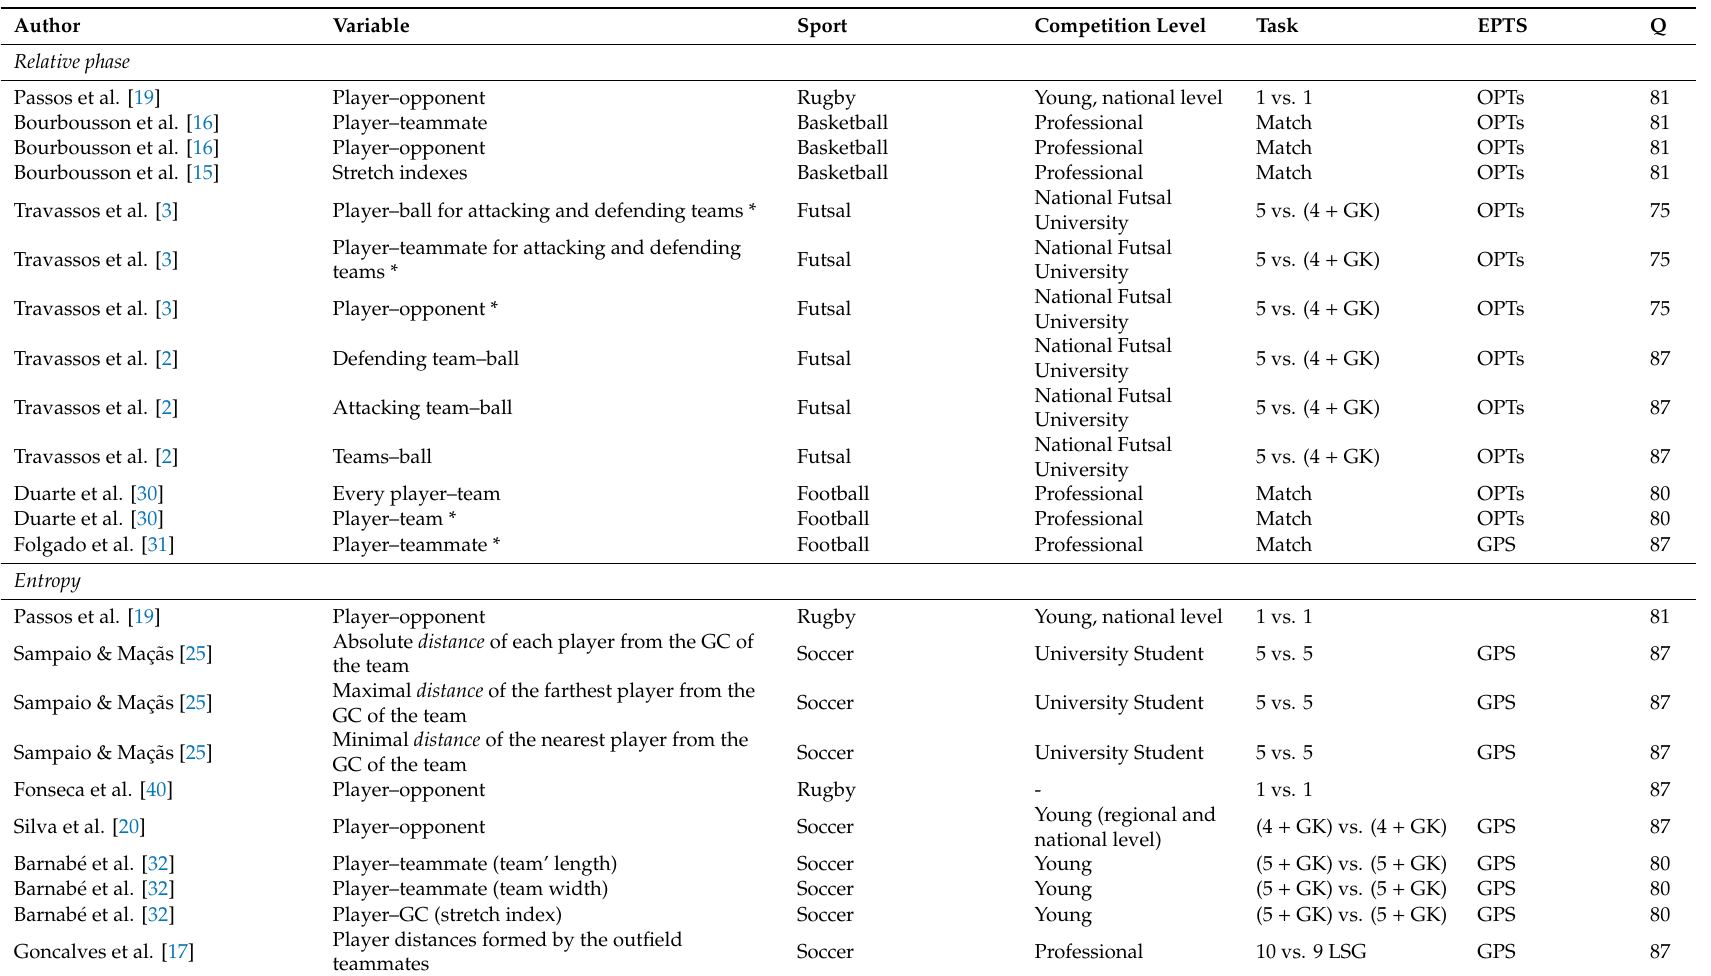
Table 3. Origin and modifications of the application of the data processing techniques in the distance